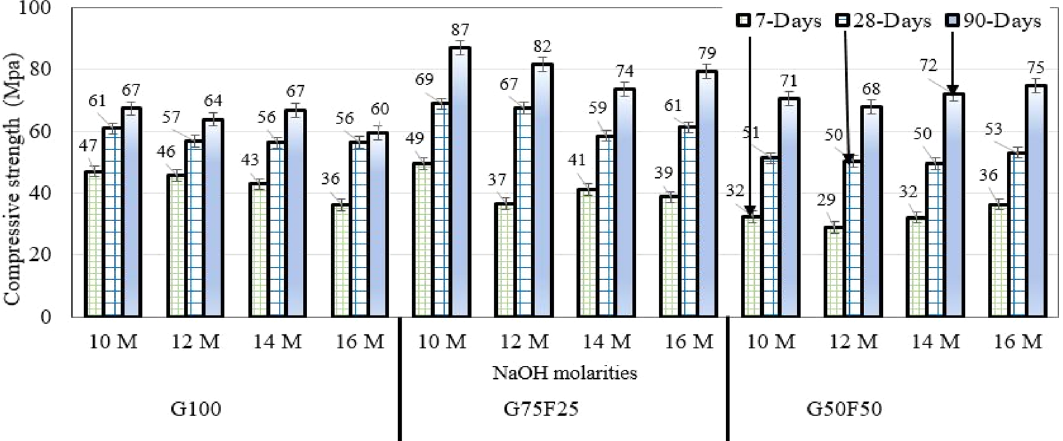
Figure 4. Compressive strength development for water-cured mortar prepared with NaOH molarities of 10M, 12M, 14M, and